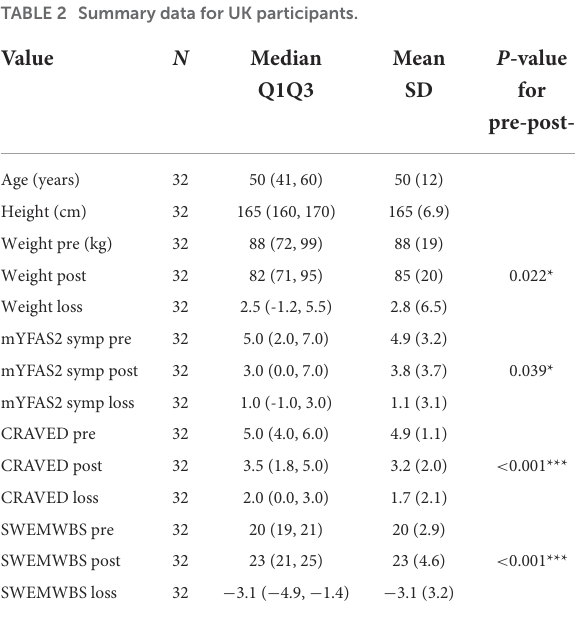
TABLE 2 Summary data for UK participants.